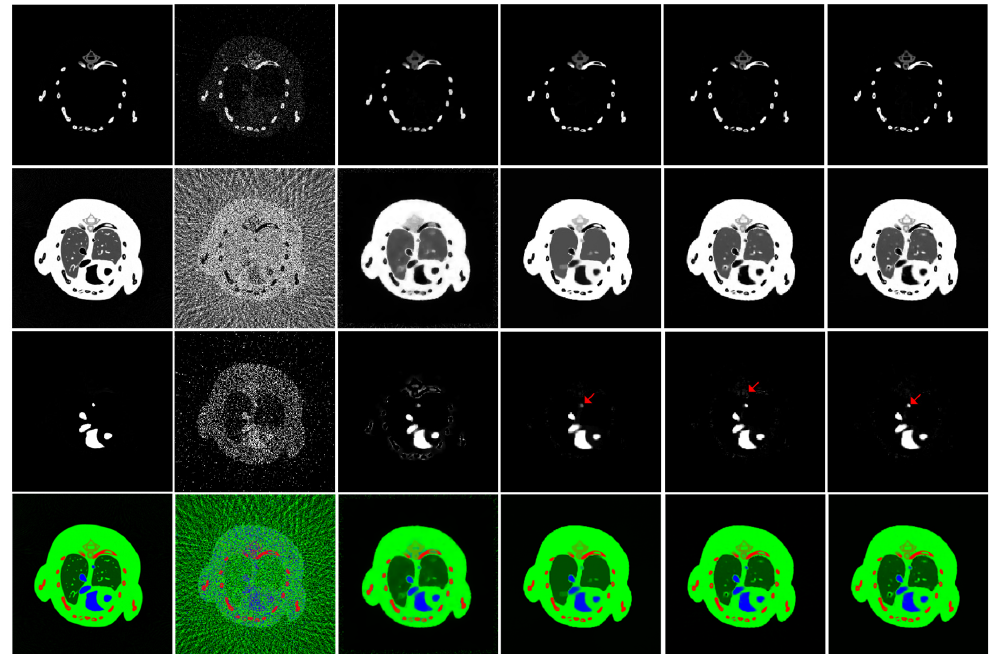
Figure 7. Material decomposition results from 80 views. From top to bottom rows, the first three rows are the decomposed bone, soft tissues, and iodine contrast agent components, respectively. The fourth row is the color representation of the corresponding basic materials. From left to right, the columns are Ground truth, FBP, TV, TVLR, TDL, and our algorithm.